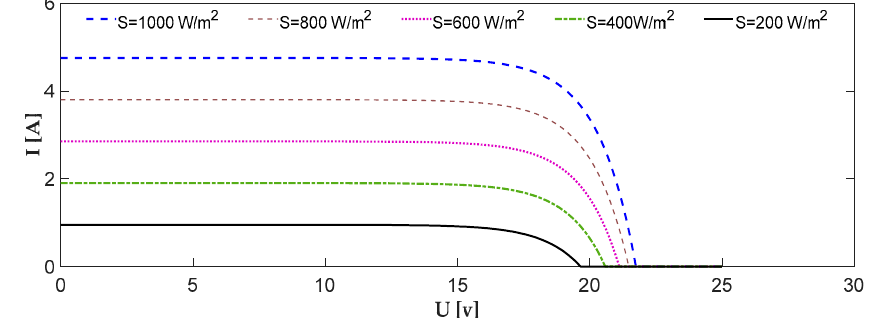
Figure 6. I–V (current flow versus voltage) curves of photovoltaic cells at T = 25 °C.